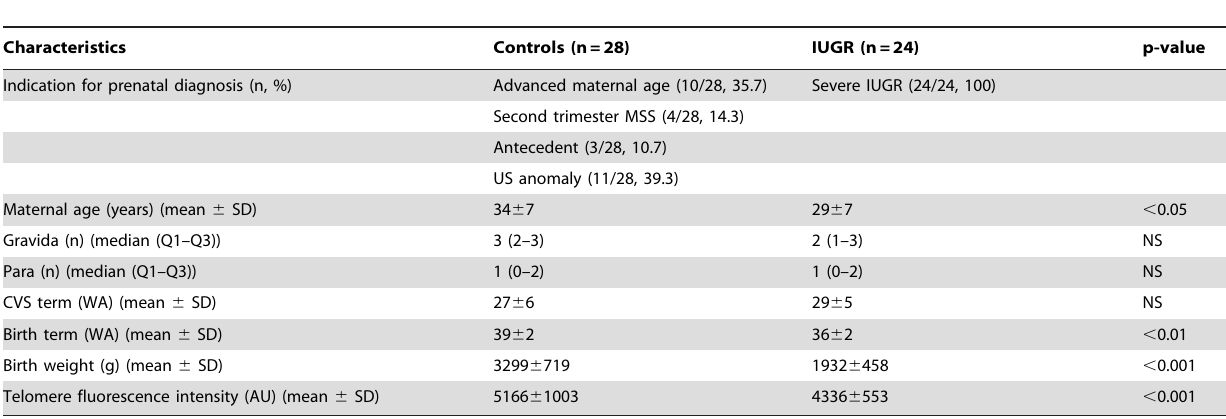
Table 1. Main characteristics of the subjects and their pregnancies.